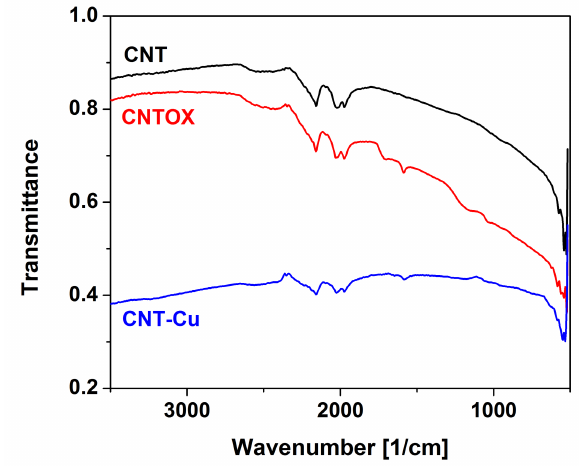
Figure 5. FTIR spectra of the as-made CNT, CNTOX and CNT-Cu